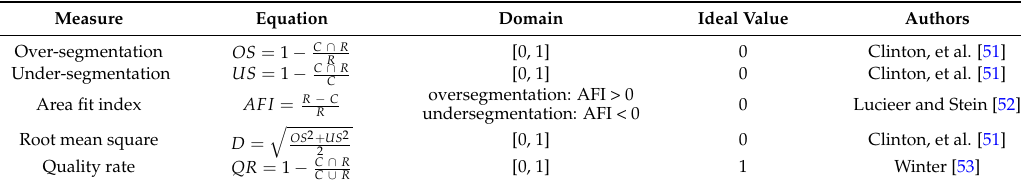
Figure 2. Proposed workflow to partition a scene into objects starting from pixels and superpixel level, respectively, by applying Estimation of Scale Parameter 2 (ESP2) [6], an automated parameterization tool for multiresolution segmentation (MRS) [14]. The computational time is retained for both cases. Resulted objects were geometrically compared with the reference objects and segmentation accuracy measures were derived. For the classification scenarios, the final accuracies were compared between pixel-based, object-based and superpixel-based classification. Table 2. Overview of the selected segmentation accuracy measures ( C indicates the total area of evaluated objects; R indicates the total area of reference objects).